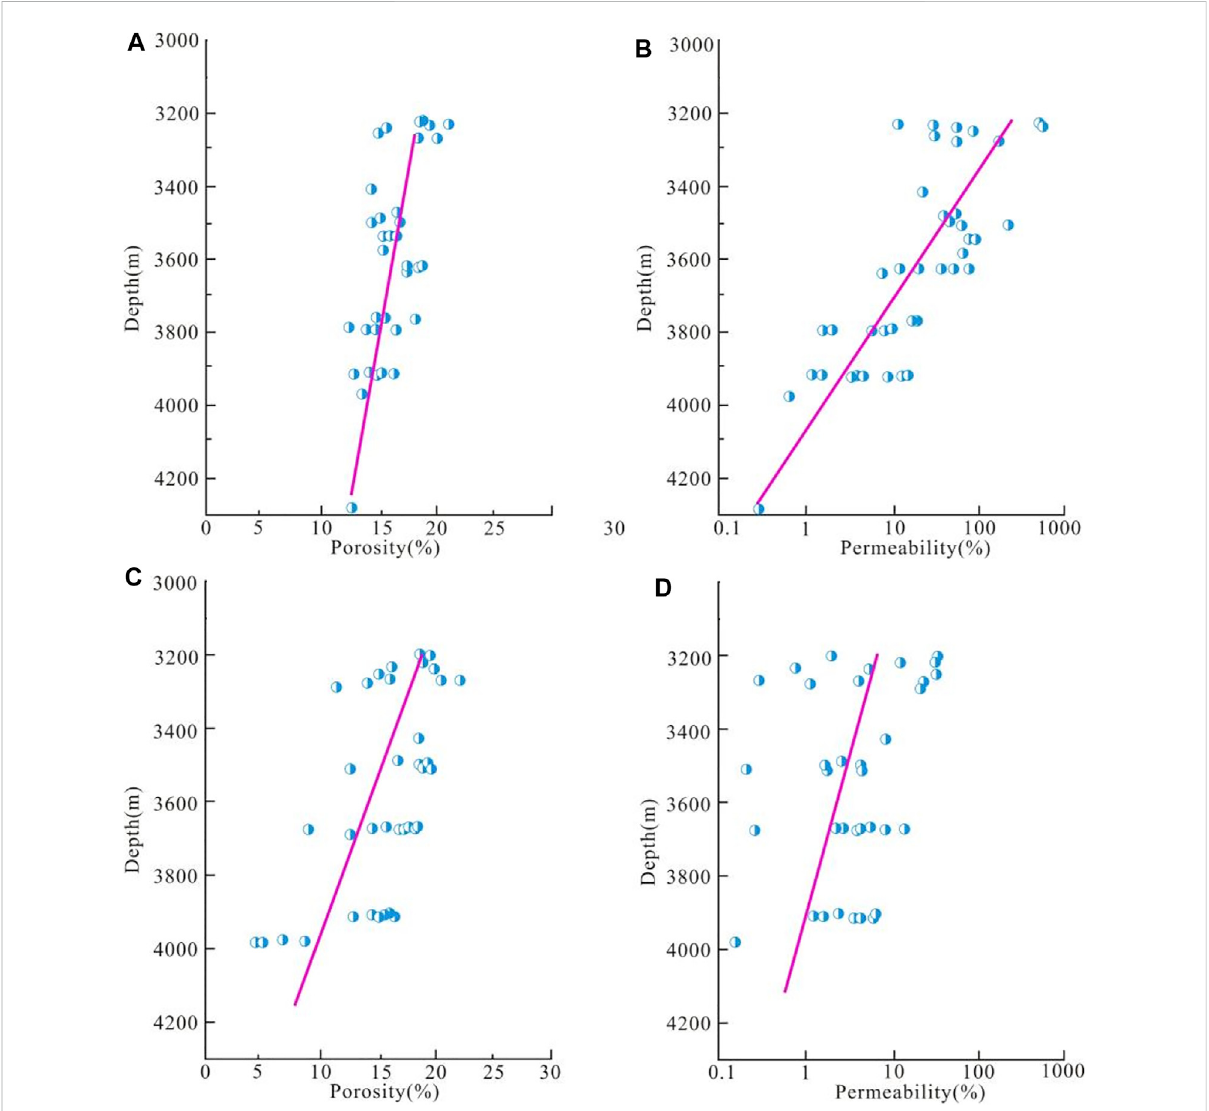
FIGURE 8 Physical propertiesoftheunderwaterdistributarychannelandestuarydamreservoirschangewithburieddepth. (A) .Variationofporosity ofthe underwaterdistributarychannelreservoirwithburieddepth. (B) .Variationofpermeabilityoftheunderwaterdistributarychannelreservoirwithburial depth. (C) .Variationofporosity oftheHekouba reservoirwithburieddepth (D) .VariationofpermeabilityoftheHekouba